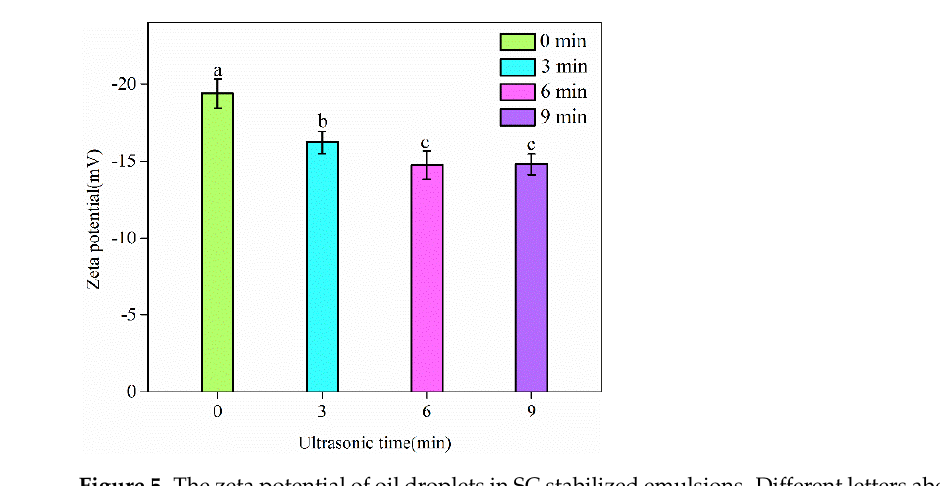
10 of 17 Figure 4. Changes in emulsifying properties of SC-coated O/W emulsions as a result of the high- intensity ultrasound treatment. Different letters above standard deviation bars are significantly dif- ferent ( p < 0.05). 3.3. Zeta Potential of Emulsions The zeta potential of SC-coated emulsions as a function of ultrasound time (0–9 min) is presented in Figure 5. The zeta potential of untreated emulsion droplets was negative ( − 19.38 mV). Zhao et al. also reported that the zeta potential of the emulsions (10% corn oil and 1% SC) of oil droplets was negative ( − 23.15 mV) [6]. This result occurred because the SC molecule presents the negative charge at a pH value higher than the isoelectric point (4.6–5.5) [27]. The ultrasound caused a significant decrease in the surface charge of SC-stabilized emulsions ( p < 0.05), suggesting that the ultrasound decreased repulsion forces among emulsion droplets. It is noteworthy that the zeta potential of SC-coated droplets showed no significant difference between 6 and 9 min of the ultrasound treat- ment ( p > 0.05). The surface charge reduction of the ultrasound treatment was attributable to the increased EAI of the emulsion (Figure 4). Sui et al. found that the decreased absolute zeta potential value was induced by protein aggregates [19]. More adsorbed proteins ag- gregated in the O/W interface could reduce the surface charge of oil droplets [21]. The change in the absolute zeta potential value of the emulsion droplets was also related to the native structure of biopolymers induced by the cavitation effect [21,50]. In addition, Silva et al. found that although the zeta potential of biopolymers was significantly influ-